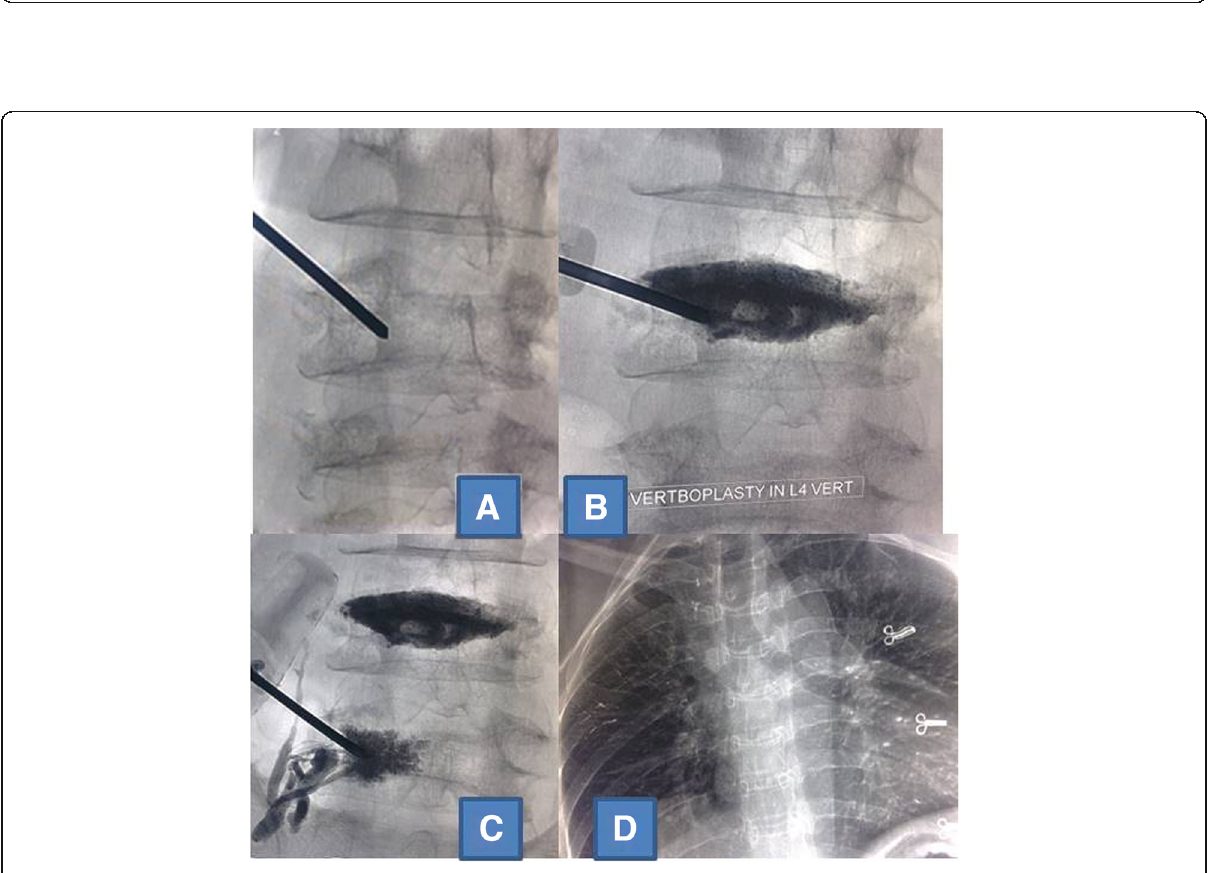
Fig. 6 A 59-year-old female with complaints of low back ache since the last 4 months. Her X-ray lumbar spine was done which shows osteoporotic collapse of L4 and L5 vertebrae. a DSA image showing transpedicular placement of needle in body of L4 vertebrae in AP view. b DSA image showing adequate filling of cement in L4 vertebral body in AP view. c DSA image C showing needle in L5 vertebral body with paravertebral venous extension of cement. d Thoracic fluoroscopy image showing linear streaks of barium in bilateral lung fields suggestive of pulmonary embolism of cement mixture. The patient had no clinical deterioration postprocedure. But the patient had intraprocedural complication of paravertebral venous extension of cement mixture extending into pulmonary embolism. So, she was closely followed up after the procedure had no clinical signs and symptoms of respiratory